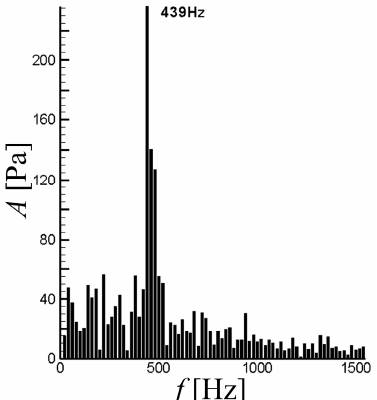
Figure 7. Frequency spectrum of static pressure by Fast Fourier Transform (FFT) analysis.